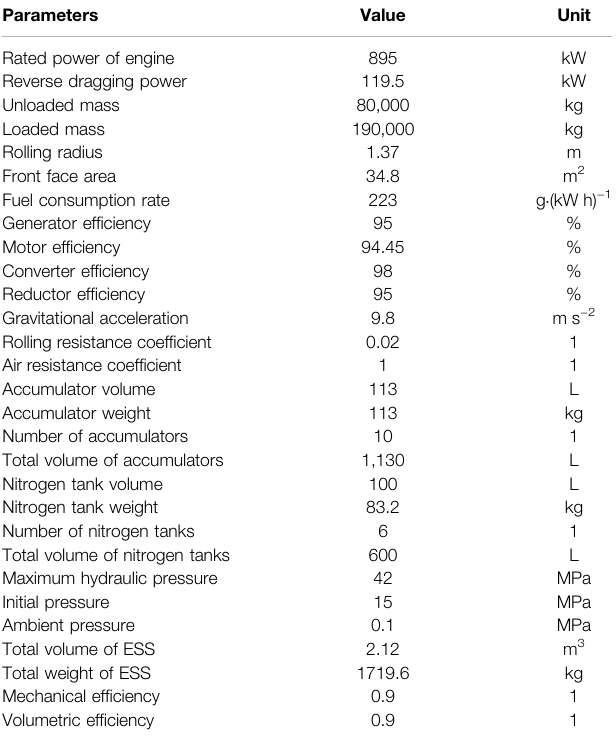
TABLE 1 | Parameters of the vehicle and